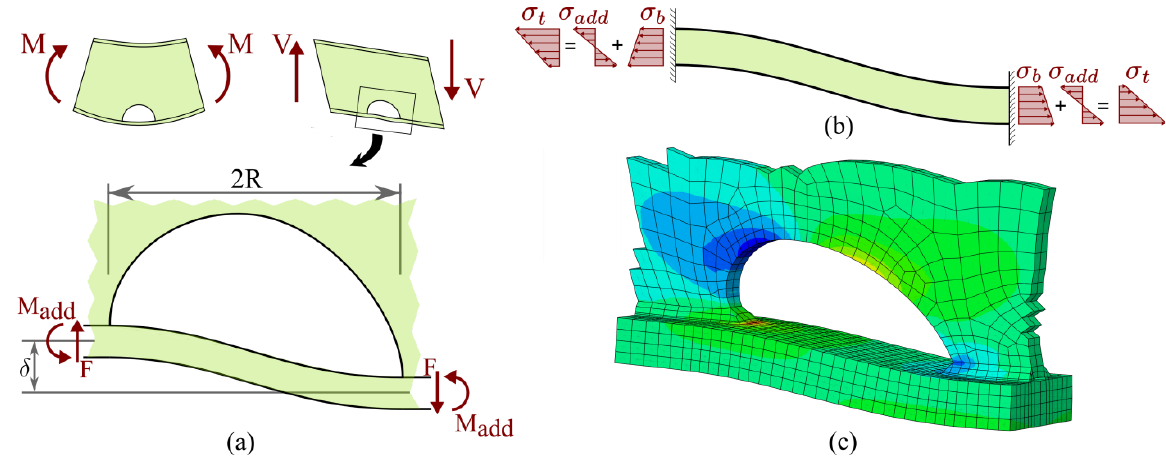
Figure 23. ( a ) Bending and shear deformation of a section with cope-hole; ( b ) Stress distribution through flange thickness at weld toe; ( c ) 3D finite element